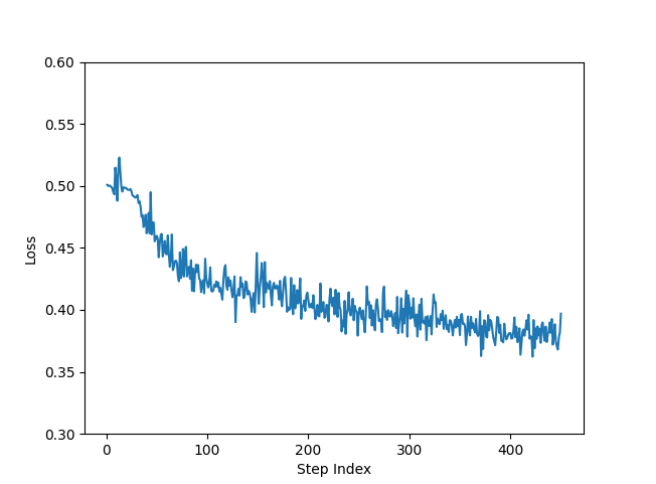
Figure 6 . Examples of batch loss decreasing in the training